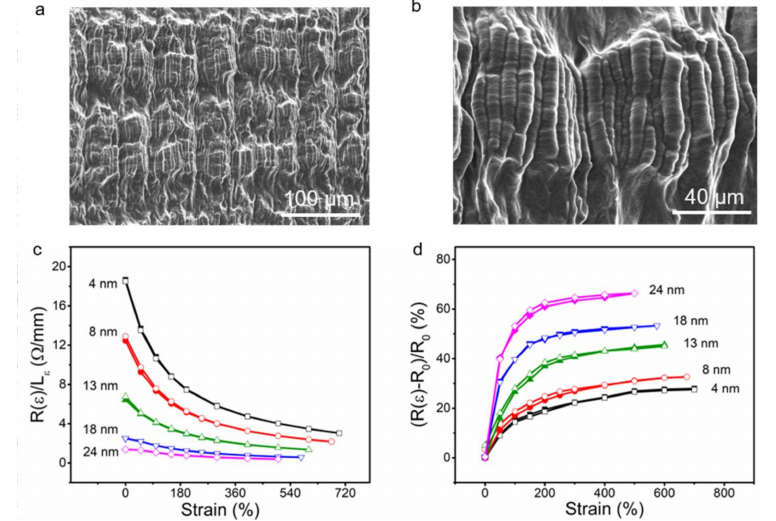
Figure 4. Low- ( a ) and high- ( b ) magnification SEM images of the (Cu 13nm -CNTS) 3 @fiber at 0% strain. The circumferential direction is vertical and the length direction is horizontal. The resistance normalized to length ( c ) and percent resistance change ( d ) for (Cu t -CNTS) 3 @fibers as a function of applied strain with different thickness of copper layer. The solid symbols represented strain increase and the open symbols represented subsequent strain release. The fabrication strain was 800% and the fiber diameter was 2 mm for ( a – d